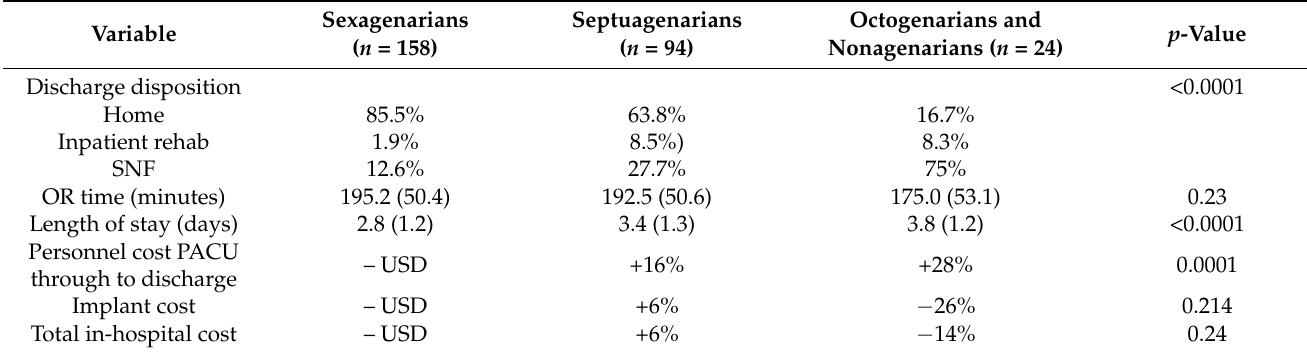
Table 3. Comparing the outcomes and costs for revision total knee arthroplasties for sexagenarians, septuagenarians, and